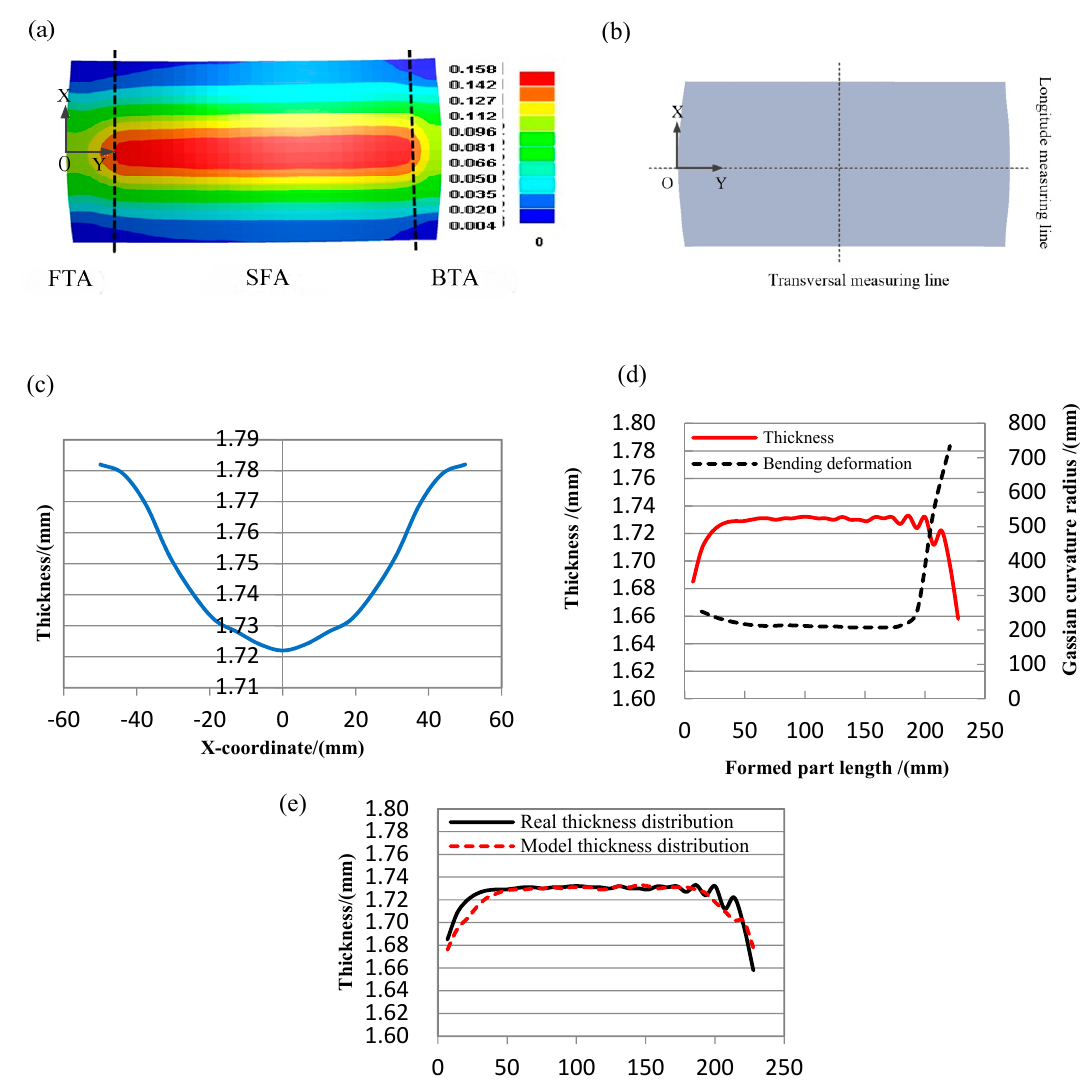
Figure 4. The formed part with ( a ) plastic strain distribution, ( b ) measuring lines in the middle of formed part, ( c ) transversal thickness distribution, ( d ) the local bending deformation and longitude thickness distribution, ( e ) and real thickness distribution and model thickness distribution.